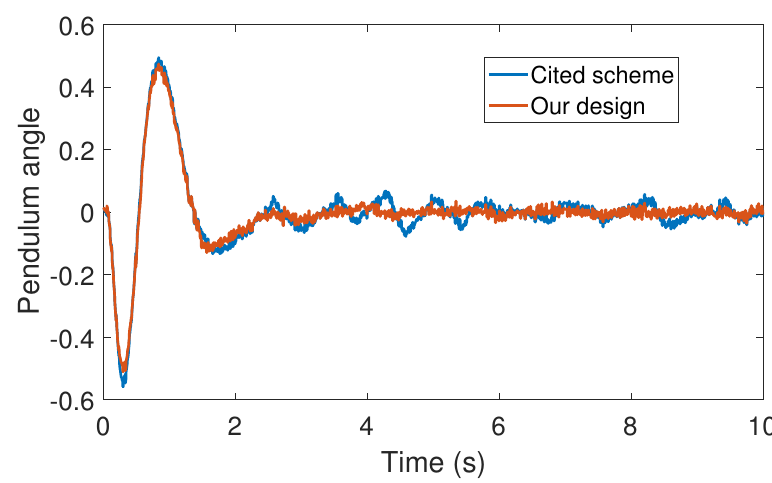
Figure 8. Numerical experiment results (noisy case): pendulum angle (Rad).